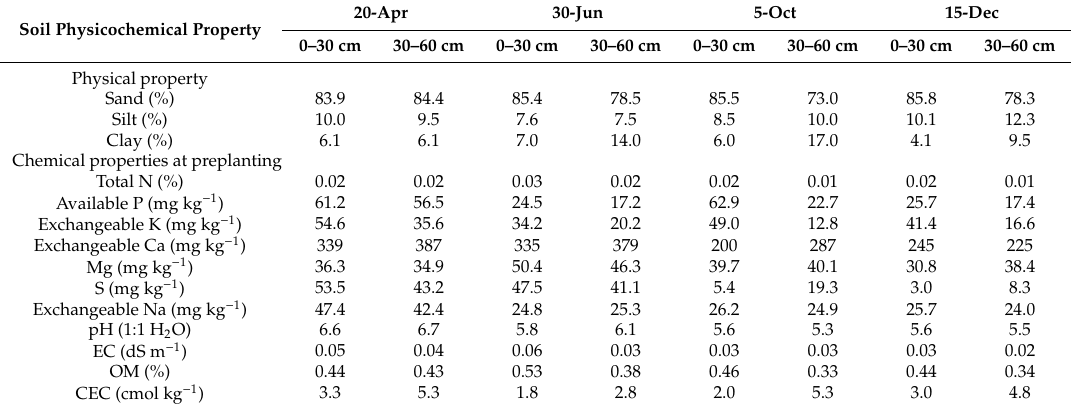
Table 1. Soil physicochemical properties at preplanting in the experimental fields at the depths 0–30 cm and 30–60